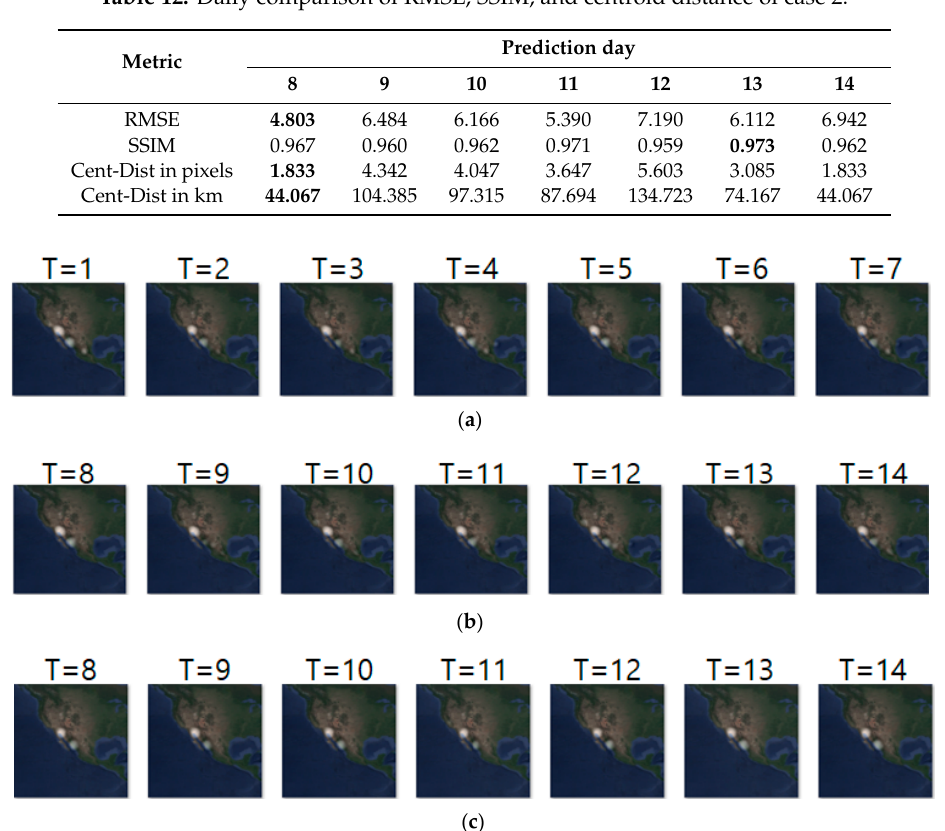
Figure 10. Movement prediction result–( a ) input sequence; ( b ) ground truth; ( c ) predicted sequence. Likewise, Figure 11a–c shows the input sequence, ground truth sequence and predicted sequence of case 4, respectively. The input and ground truth sequences indicate the migration movement of